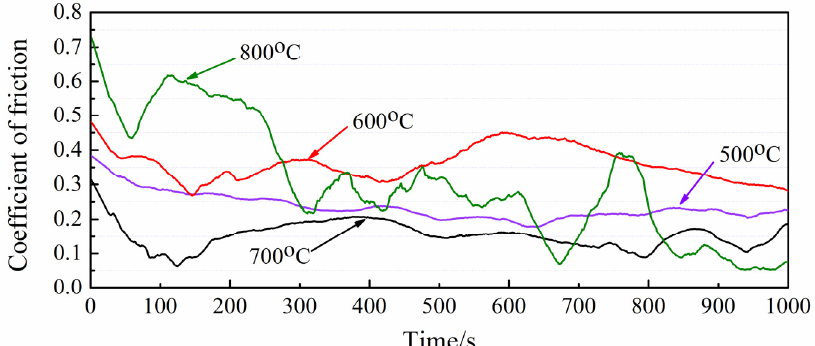
Figure 5. CoF of h-BN coatings under different temperatures.